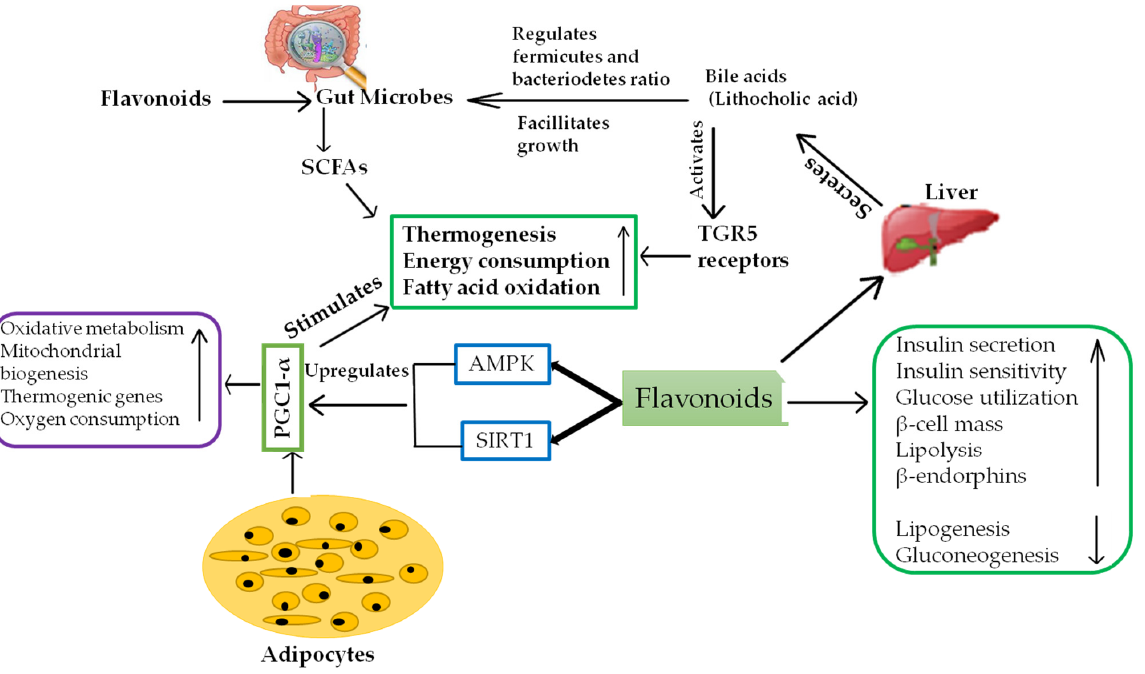
Figure 4. Diagram showing the primary mechanism that flavonoids have anti-obesity effects via different pathways.